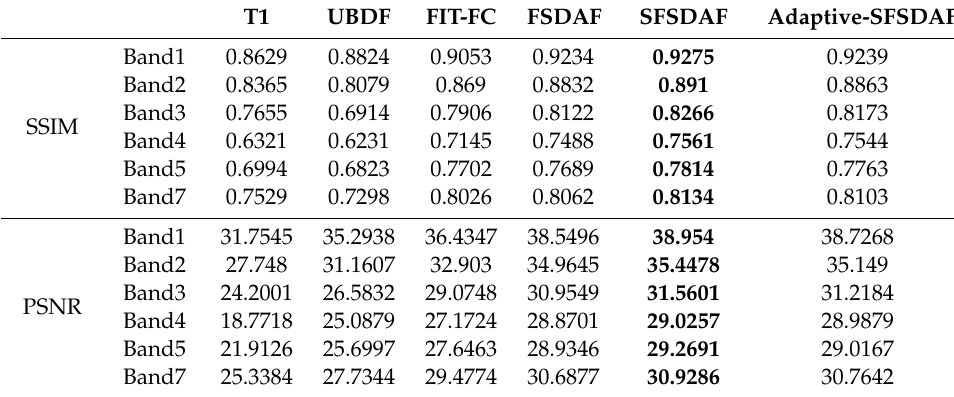
( h ) Figure 8. Magnified images in the yellow box shown in Figure 7b: original Landsat image on 26 November 2004 ( a ), original MODIS-like and Landsat images on 12 December 2004 ( b, c ), and the images predicted by UBDF( d ), FIT-FC( e ), FSDAF( f ), SFSDAF( g ), and adaptive-SFSDAF( h ).